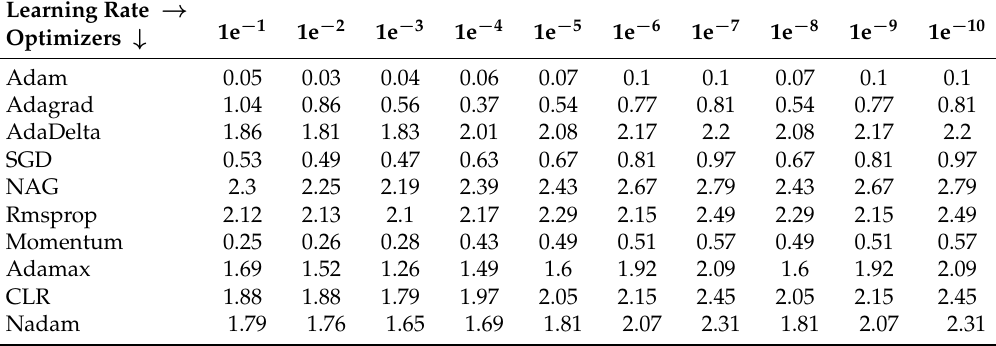
Table 10. Error rate of ten optimizers with various learning rates on a proposed patch-wise model architecture of CNN.